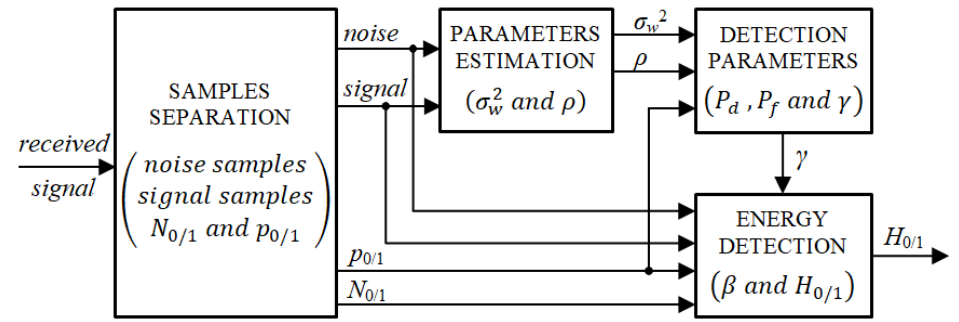
Figure 2. Block diagram of an energy detection process for discontinuous PU signals: source and demand of necessary